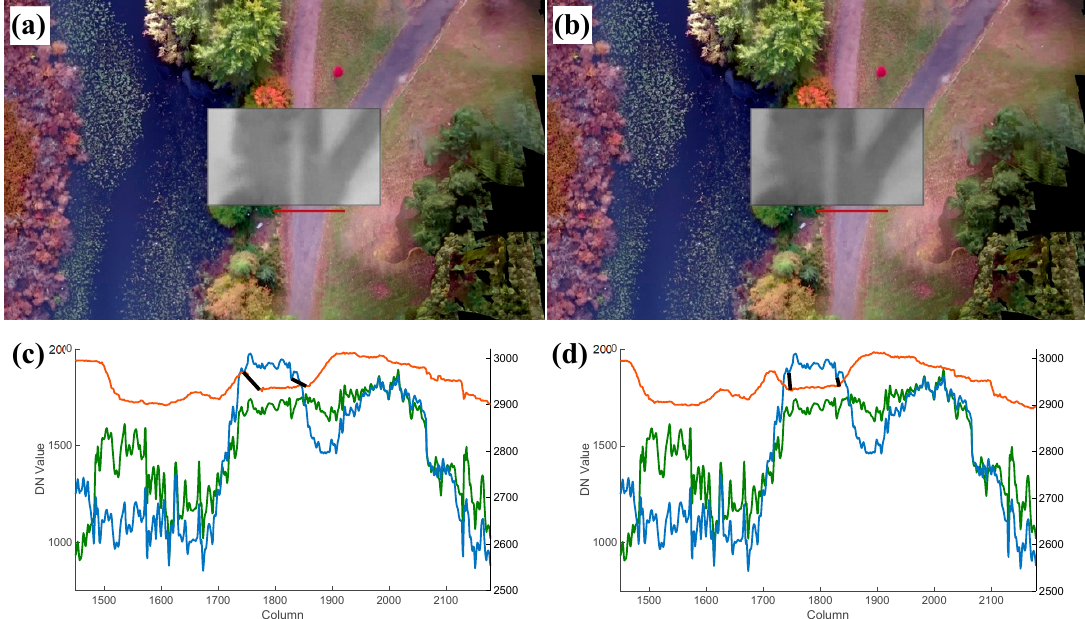
Figure 7. An example showing removal of image misalignment. ( a , b ): clipped views of the same area before and after calibration, respectively. ( c , d ): band profiles along the transects marked in (a) and (b), with the Infrared band in red corresponding with the right y-axis, the Green band in green, and the Blue band in blue, both corresponding with the left y-axis. The black lines mark the road edges.